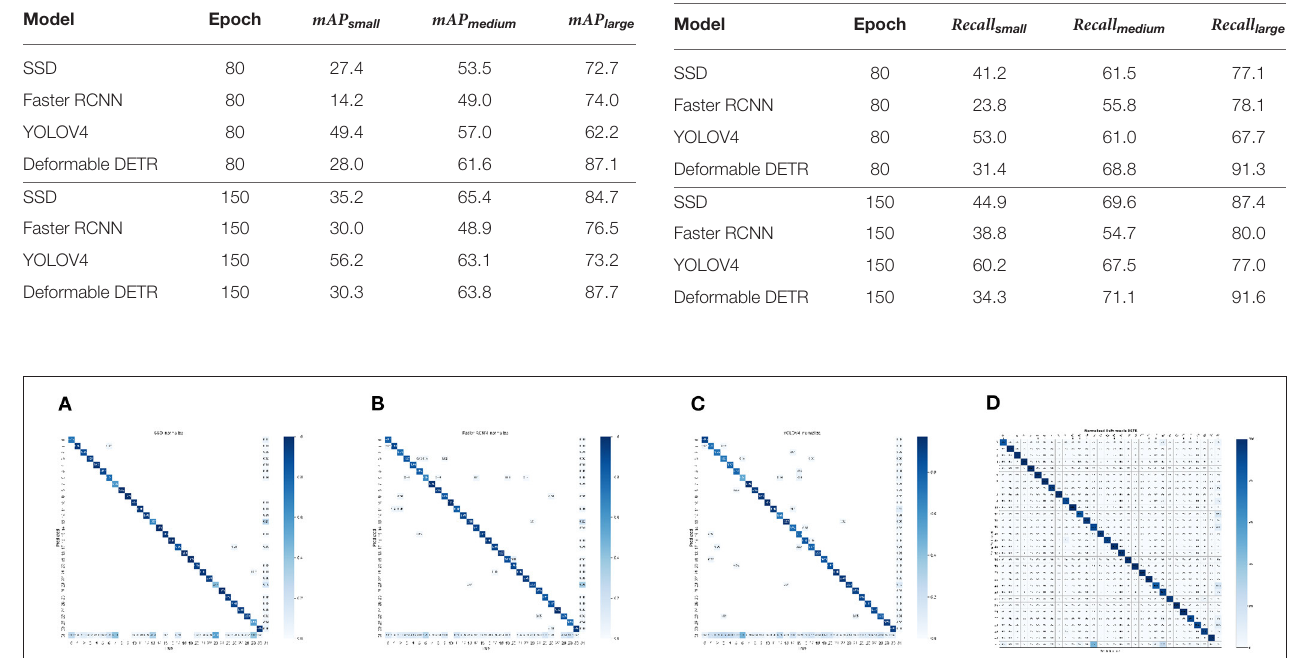
Frontiers in Plant Science | www.frontiersin.org